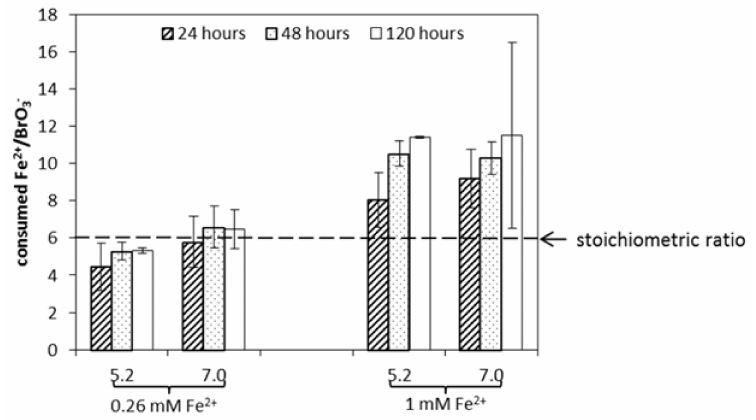
Figure 4. The consumed Fe 2+ /BrO 3 − ratios after dosing with 0.26 mM or 1 mM Fe 2+ to a solution containing 0.03 mM BrO 3 − at two initial pH levels, 5.2 and